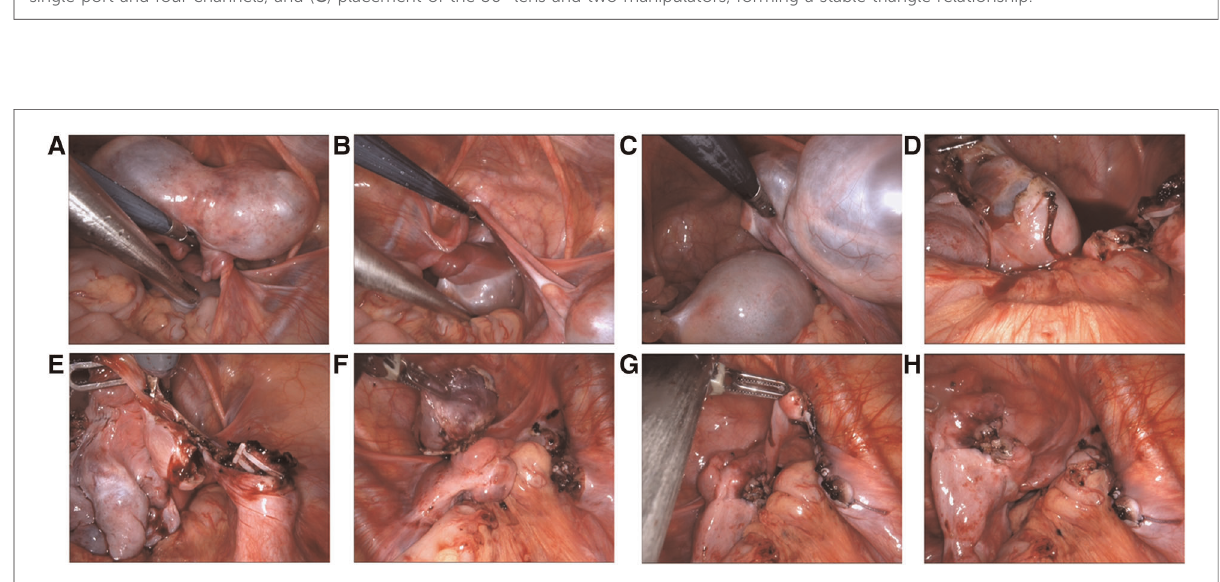
FIGURE 2 Appearance of a single incision and the placement of robotic instruments: ( A ) appearance of the single incision, ( B ) special laparoscopic device with a single port and four channels, and ( C ) placement of the 30° lens and two manipulators, forming a stable triangle relationship.